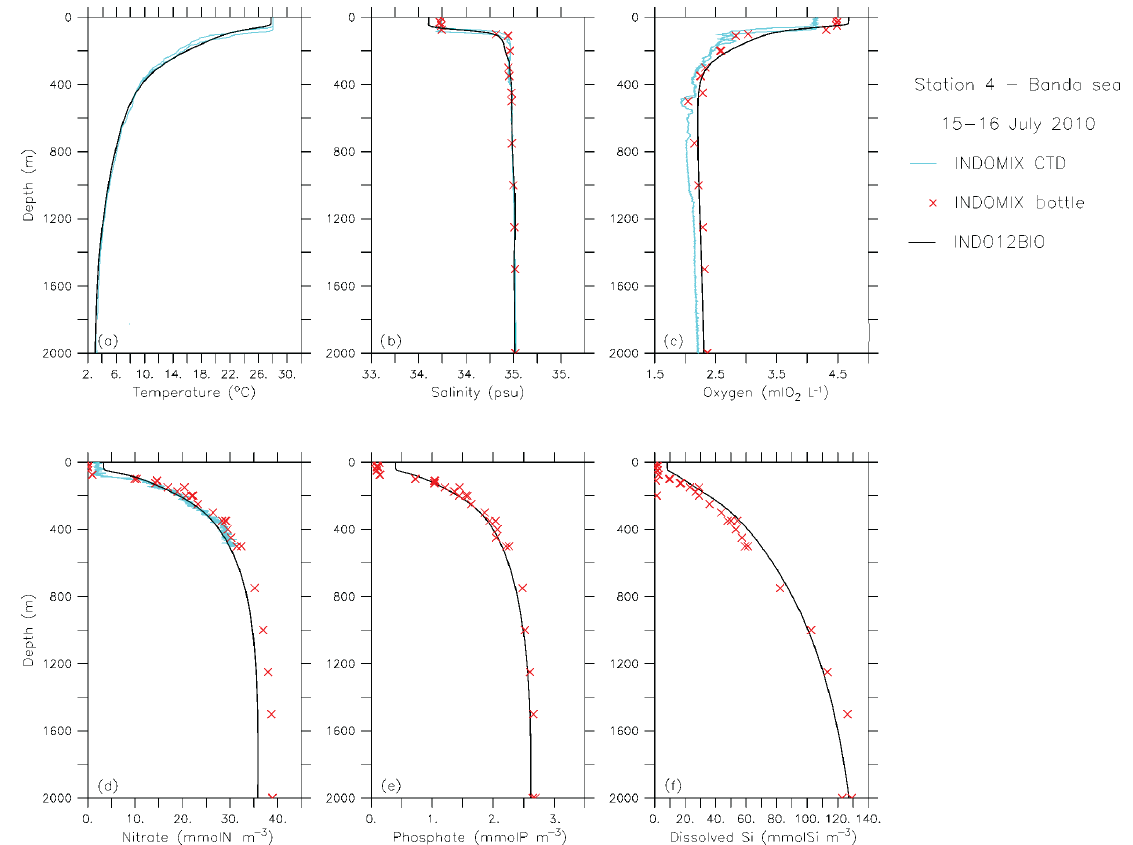
Figure 13. Vertical profiles of temperature ( ◦ C; a ), salinity (psu; b ), oxygen (mL O 2 L − 1 ; c ), nitrate (mmolNm − 3 ; d ), phosphate (mmolPm − 3 ; e ) and dissolved silica (mmolSim − 3 ; f ) concentrations at INDOMIX cruise station 4 (Banda Sea; 15–16 July 2010). CTD (light blue lines) and bottle (red crosses) measurements represent the conditions during cruise, 2-day model averages are shown by the black